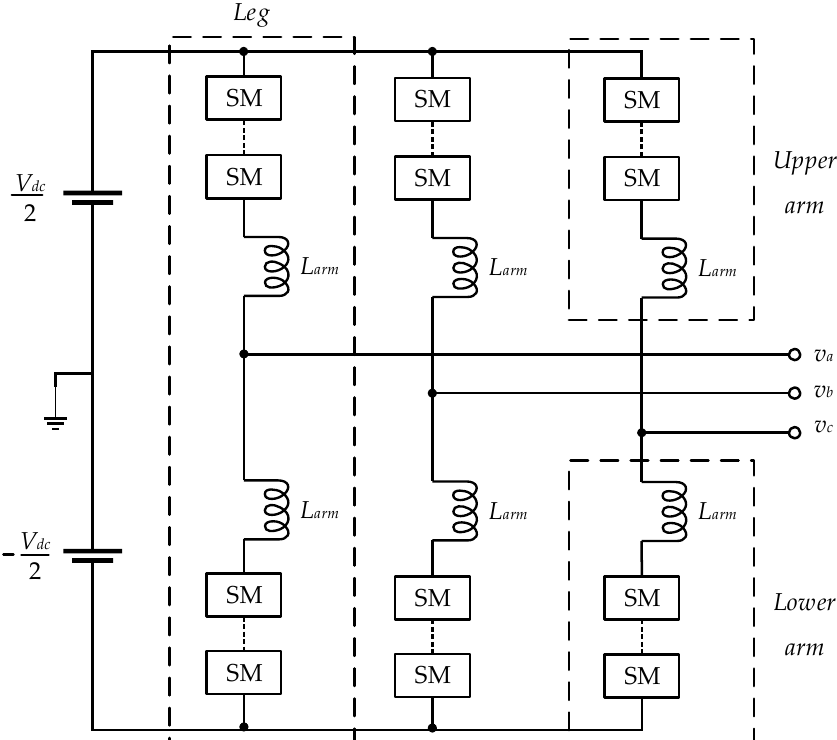
Figure 1. Generalized configuration of a three-phase modular multilevel converter (MMC).